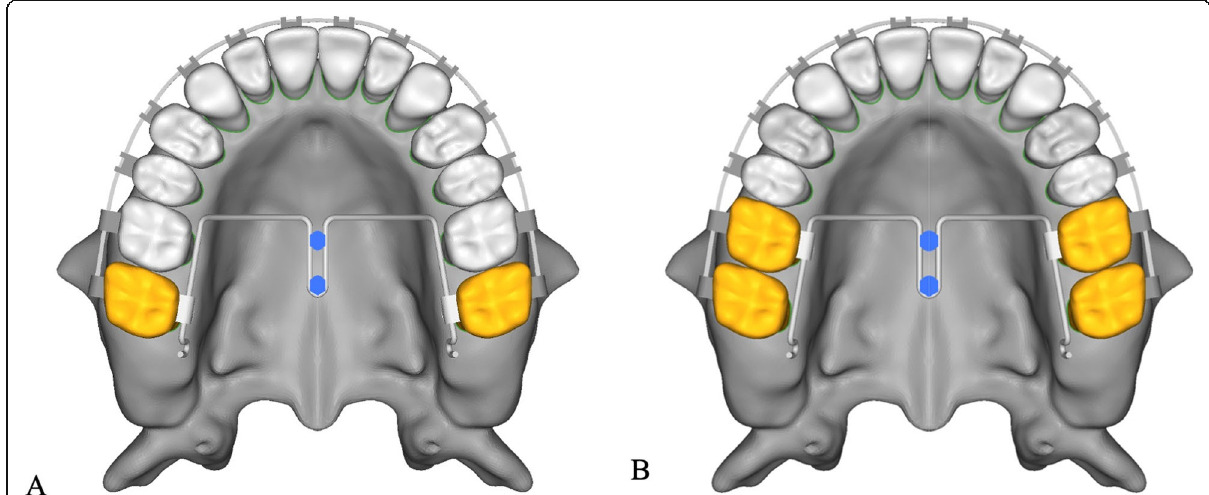
Fig. 1 Experimental conditions: a The iPanda was attached to the second molar to simulate one molar distalization. b The iPanda was attached to the first molar to simulate two molars distalization